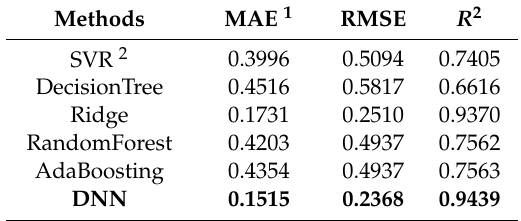
Table 3. Comparison of metrics.